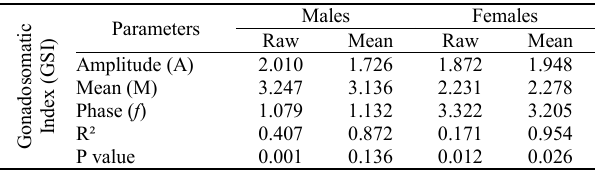
Table 1. Parameters of the sinusoidal equation for the variation of raw data and bimonthly means in the GSI of the catfish Auchenipterichthys longimanus collected from July 2008 to July 2009 in the Caxiuanã National Forest.